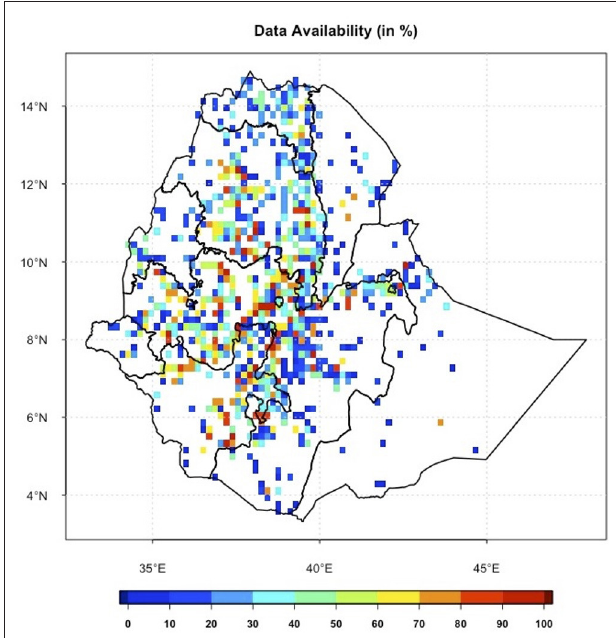
FIGURE 3 | An example data availability assessment showing what percent of data is available for each station.